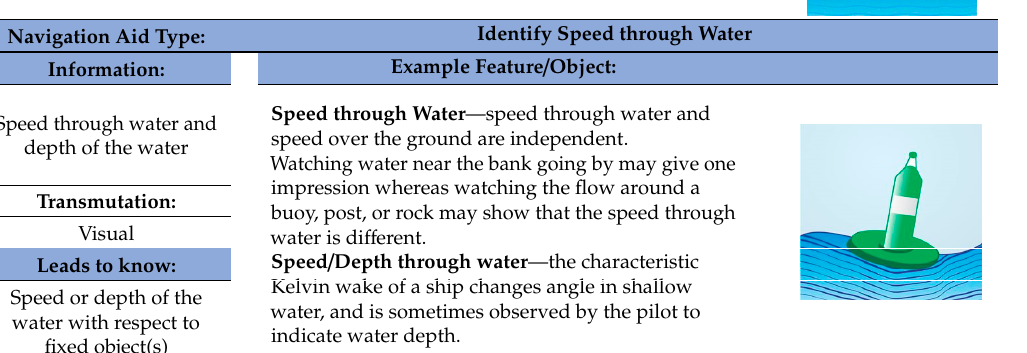
every 10 s. Special Marks —show a special area or feature. For example, to show that a channel divides or to mark cables or pipelines. Special marks are yellow and sometimes have a yellow X as the top mark. At night, the flashing light is yellow. Emergency Wreck Marking Buoys —used to identify new dangers or wrecks. They have blue and yellow vertical stripes and are a pillar or spar shape with a yellow cross as the top mark. At night, the flashing light alternates between 1 s of blue light and 1 s of yellow light, with 0.5 s of darkness in